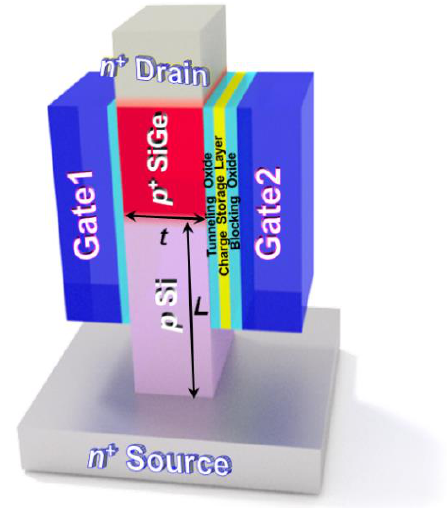
Figure 1. Schematic of the proposed synaptic device having an embedded SiGe quantum well and charge-storage layer for realizing the short-term and long-term plasticity, respectively. As the number of potentiation pulses increases, the electrons in the SiGe valence band tunnel into the drain conduction band and fill the empty energy states. As a result, the holes generated in the SiGe layer are confined in the layer owing to a large valence-band o ff set (VBO) between Si and